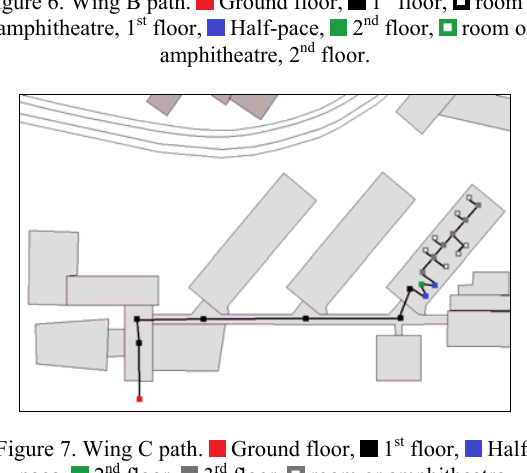
Figure 6. Wing B path.